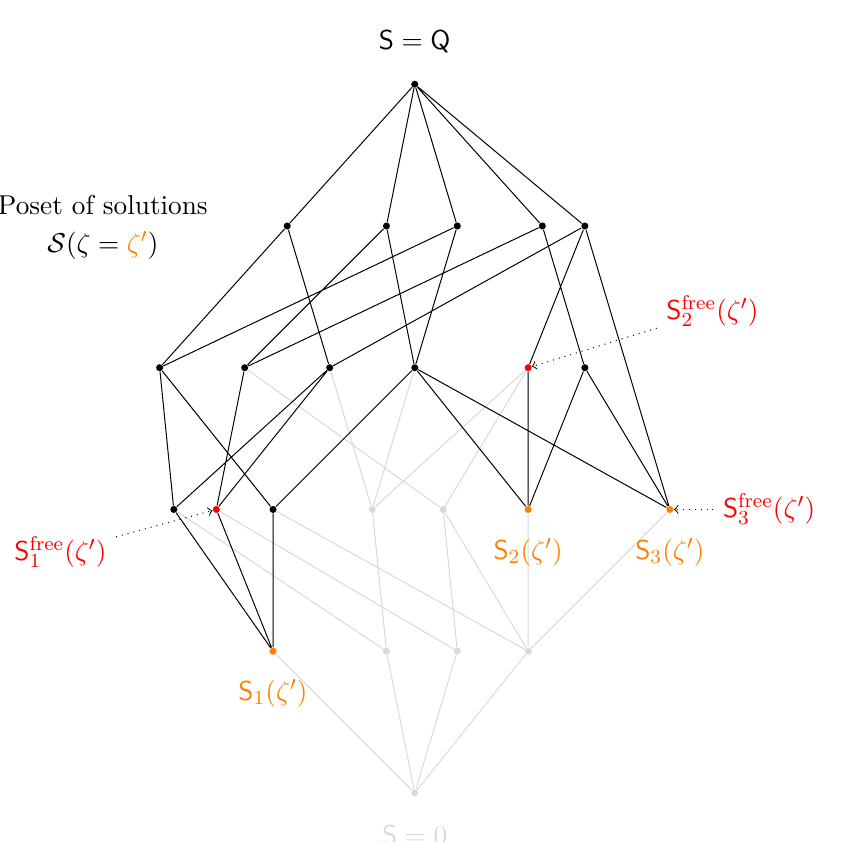
( ζ 0 ) = S ( ζ 0 ) . If they are not, they 3 3